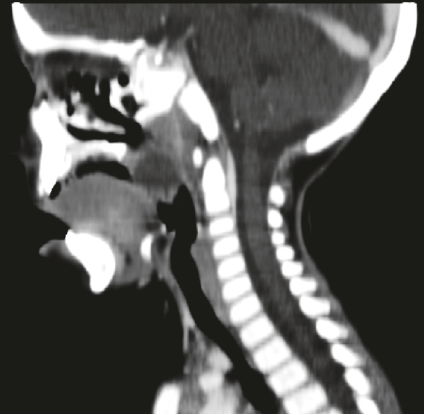
Figure 2: Sagittal view consistent with peritonsillar